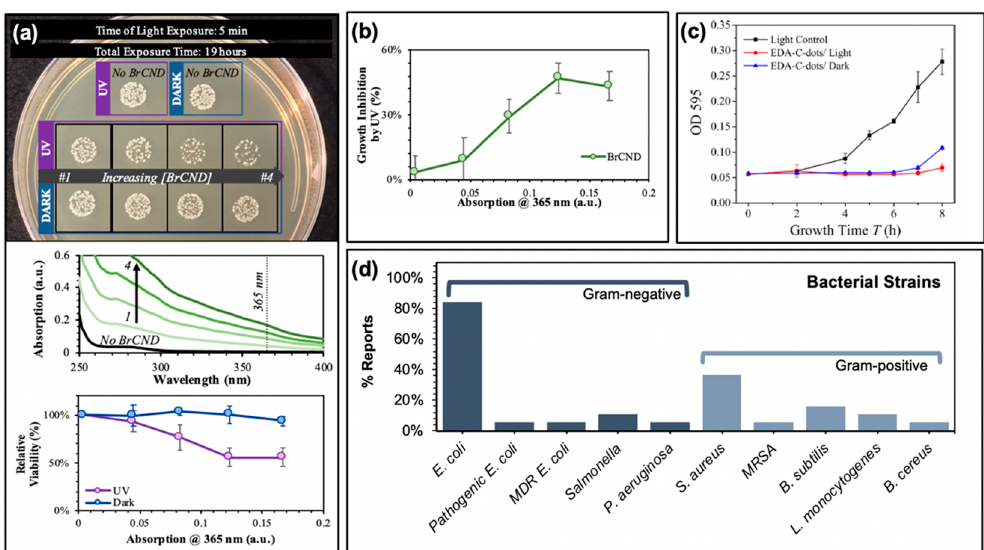
Figure 4. Photodynamicantimicrobialcharacteristicsofcarbonnanodots. ( a ) Top —Concentration-dependent growth reduction of Staphylococcus aureus exposed to brominated carbon nanodots (BrCND). Middle —Absorption spectra for BrCND of varying concentrations, corresponding to solutions used in top panel. Bottom —Relative viability of bacterial samples under both dark and light-exposed conditions (from Reference [56]). ( b ) Photodynamic inhibition of bacterial growth from ( a ) (from Reference [56]). ( c ) Bacterial growth curves of Escherichia coli samples after photodynamic treatment with carbon nanodots (EDA-C-dots). ( d ) Summary of investigated bacterial strains in the references reported by this review. For additional details regarding the reported studies, the reader is referred to Table 1 of the main text. Abbreviations: CDs (carbon nanodots). Permissions : ( c ) Adapted with permission from Reference [26]. Copyright © 2016,